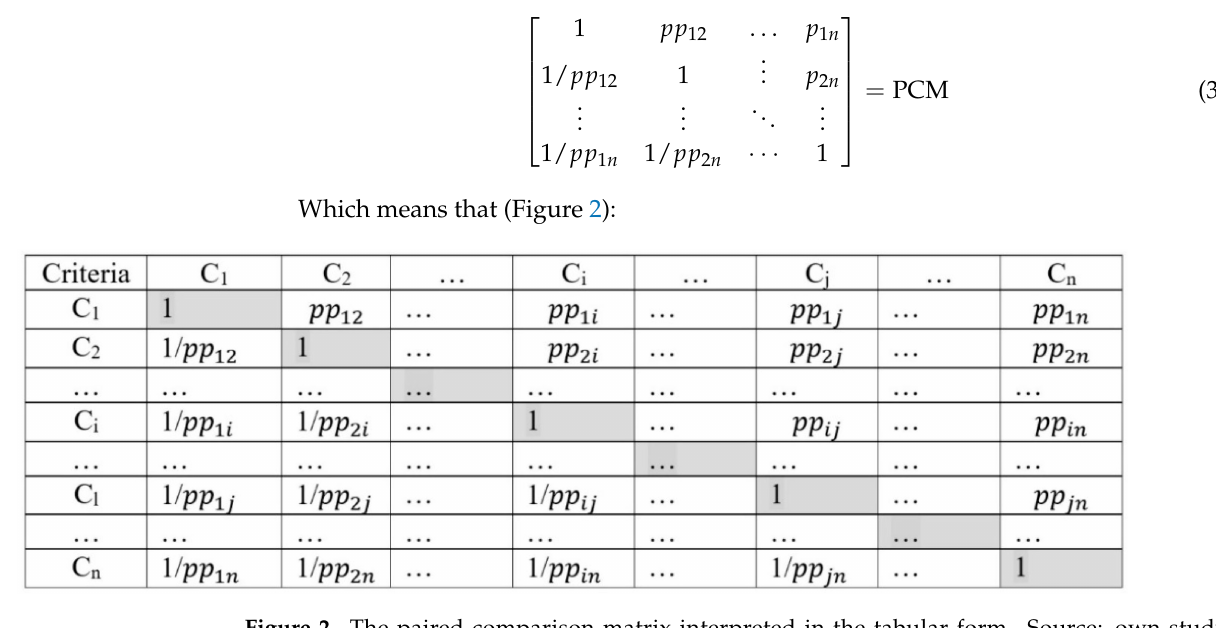
Figure 2. The paired comparison matrix interpreted in the tabular form. Source: own study based on [31,39].